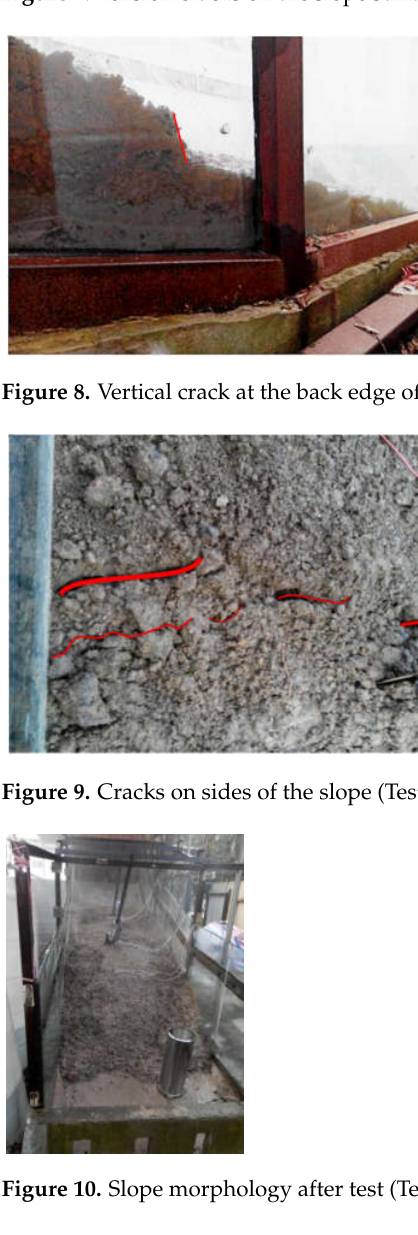
Figure 7. Tension cracks on the slope surface (Test 1).